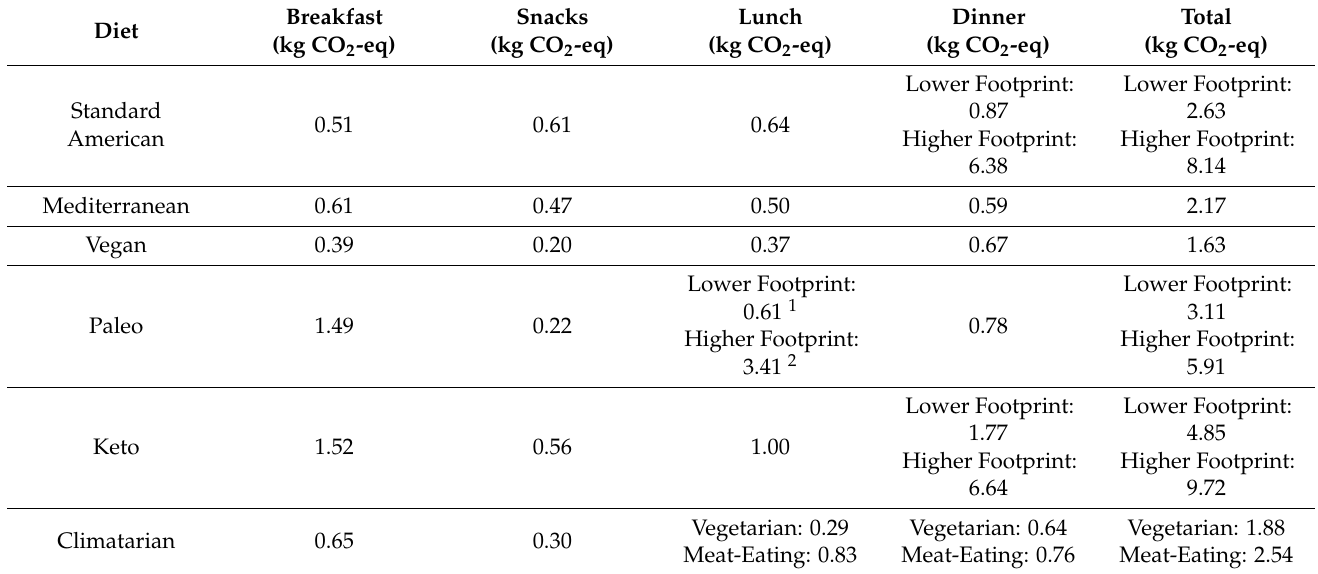
Table 2. Summary of Carbon Footprint